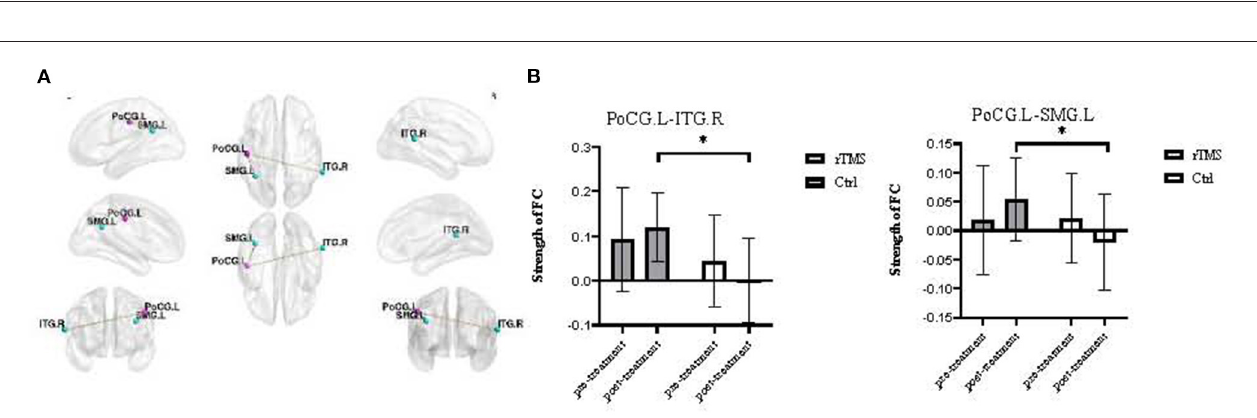
FIGURE 5 | Significantly different FC after treatment between the two groups (voxel p < 0.01, cluster p < 0.05, two-tailed, GRF-corrected). (A) The results of the functional connectivity analyses with the seed region located in the PoCG.L ( − 48 − 21 39). (B) The panel displays the FC strength values from PoCG to ITG.R and SMG.L. PoCG, postcentral gyrus; ITG, inferior temporal gyrus; SMG, supramarginal gyrus. * P < 0.05, Treatment group compared with control group at the same timepoint.